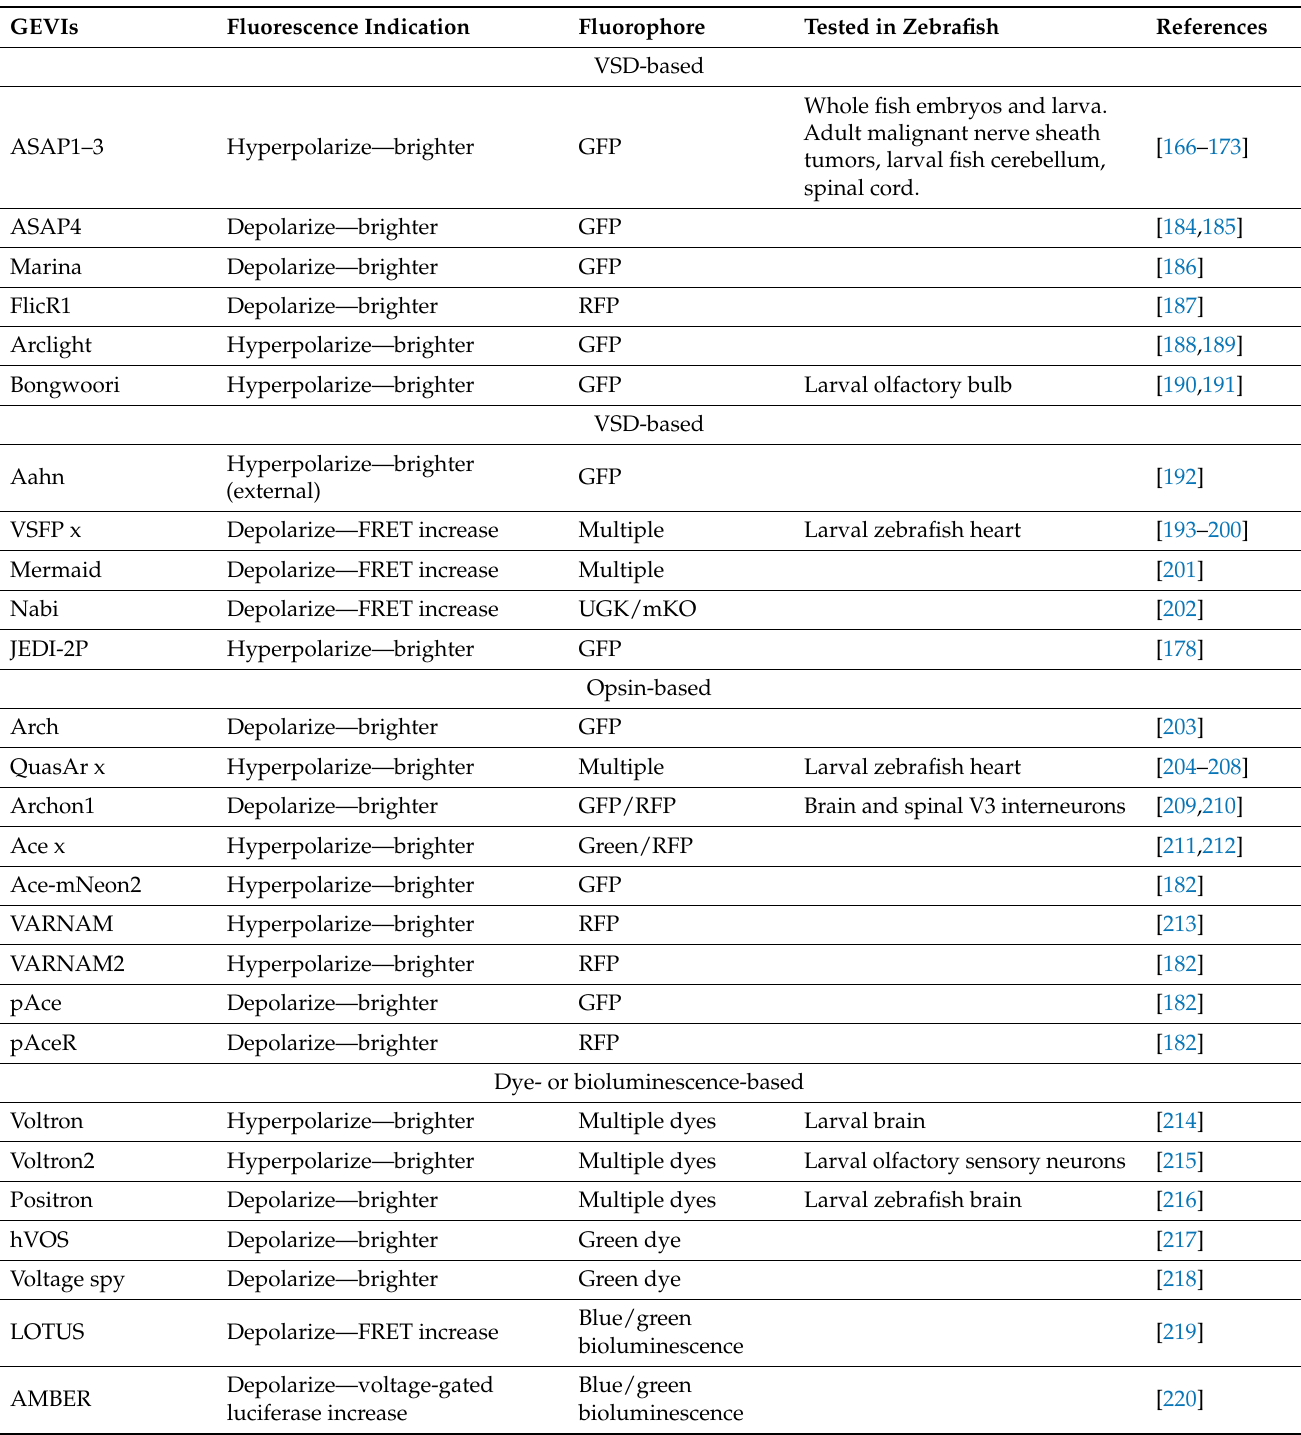
Table 3. List of published genetically encoded voltage